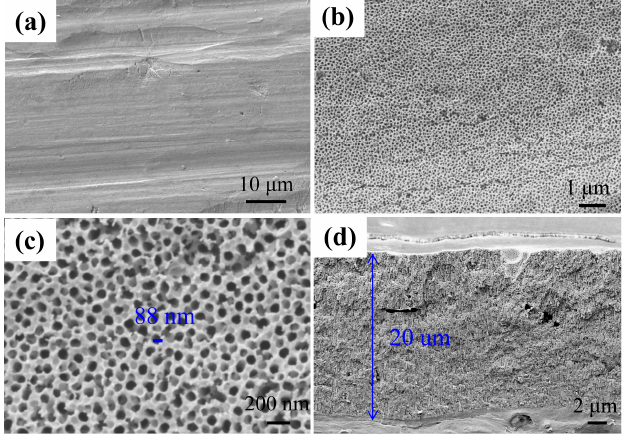
Figure 2. Scanning electron microscope (SEM) images: ( a ) bare aluminum, ( b,c ) top view, and ( d ) Figure 2. cross-section of anodic aluminum oxide (AAO).